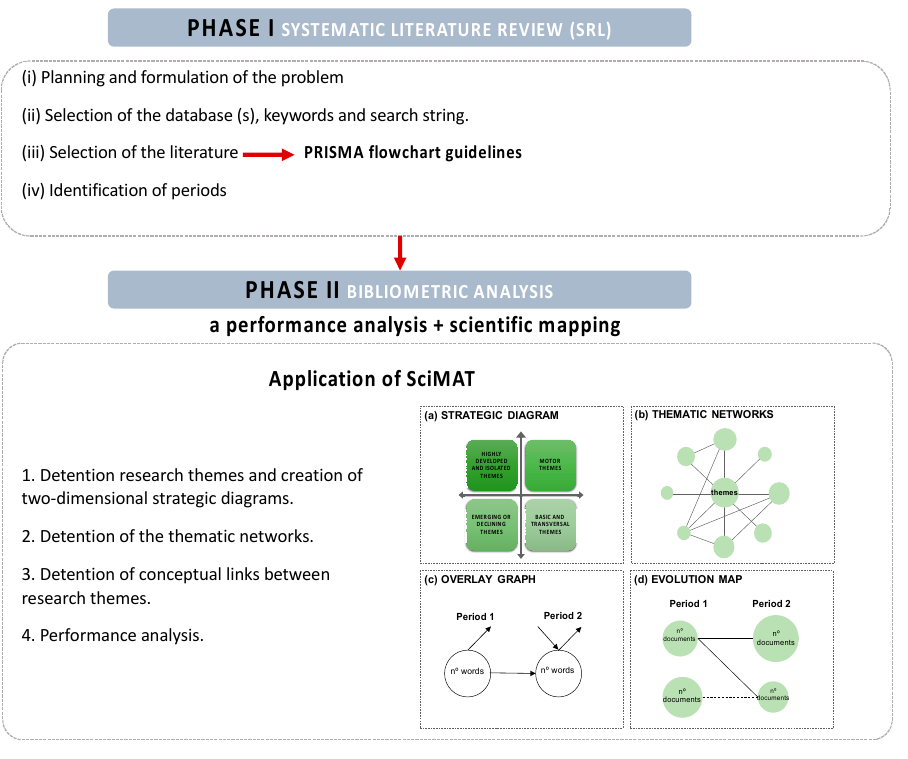
Figure 1. Materials and methods in addition to examples of a strategic diagram ( a ); thematic network ( b ); overlay graph ( c ); and evolution map ( d ).